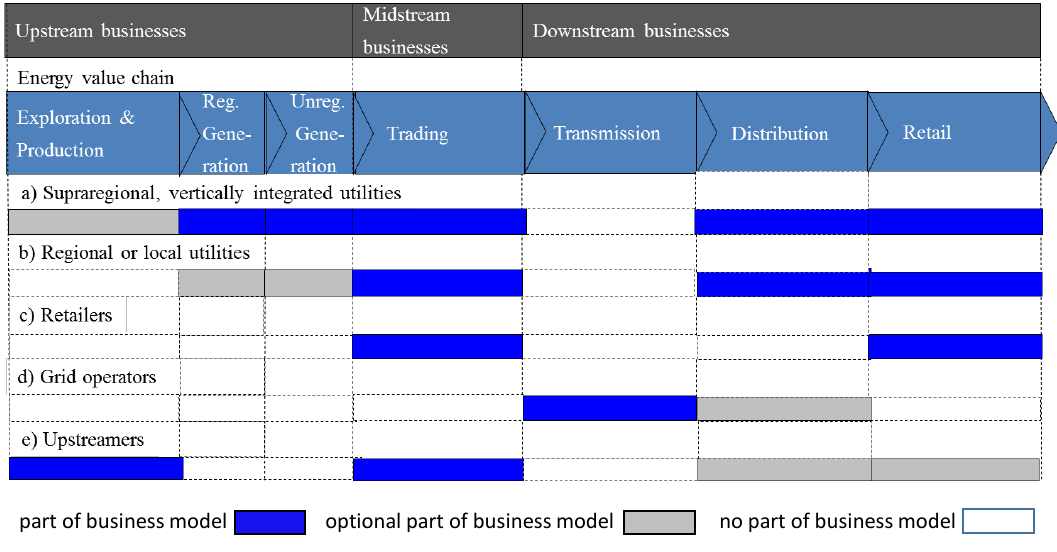
Figure 8. Overview of the most important generic business models in the liberalized German energy market. Own illustration, based on [22] (pp. 98–99) and [25] (p. 9).